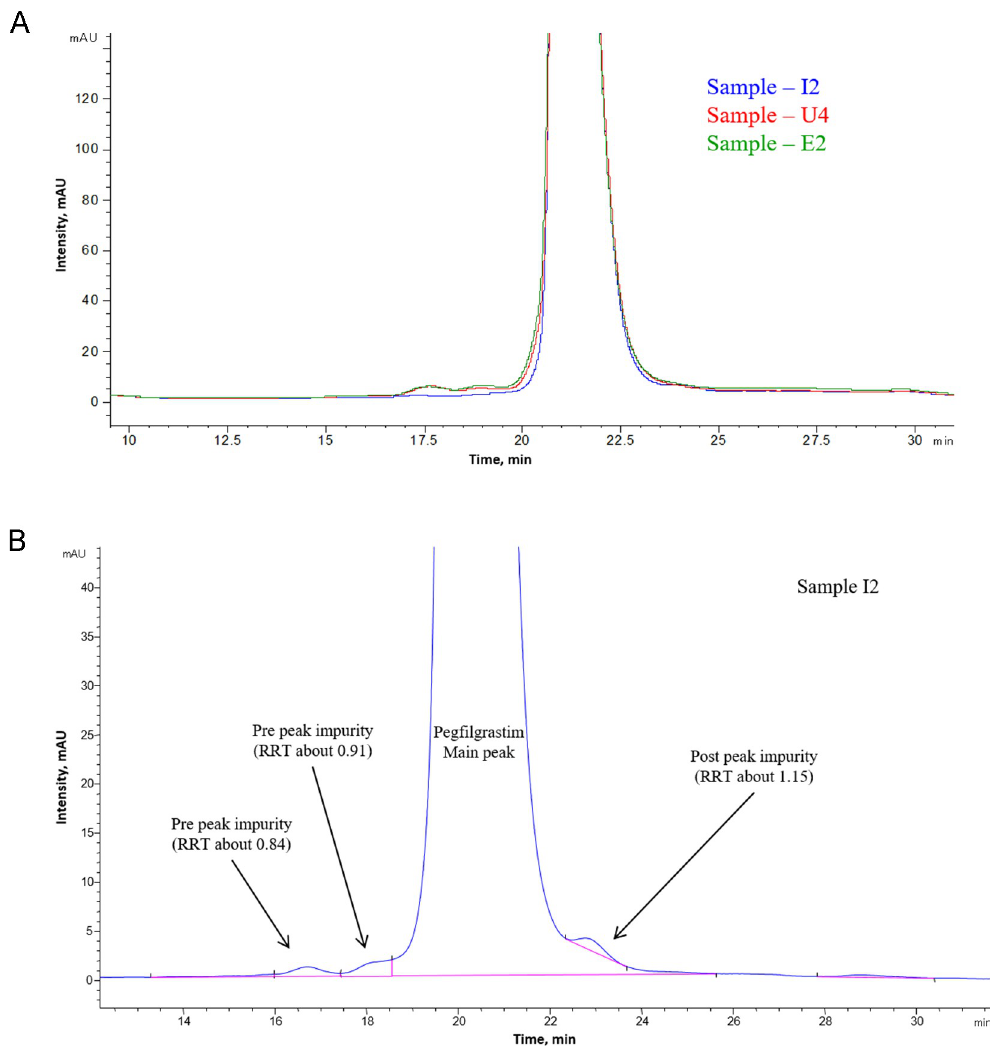
Fig 6. (A) Overlay of CEx chromatographic profile of INTP5, US Neulasta and EU Neulasta (Sample I2, U4 and E2); (B) Representative CEx-HPLC profile of INTP5 (Sample I2).